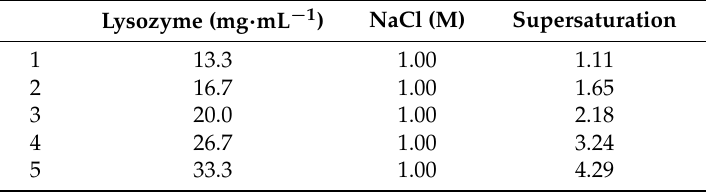
Table 1. The concentration of lysozyme crystal solutions (293 K ± 0.5 K, pH 4.50).